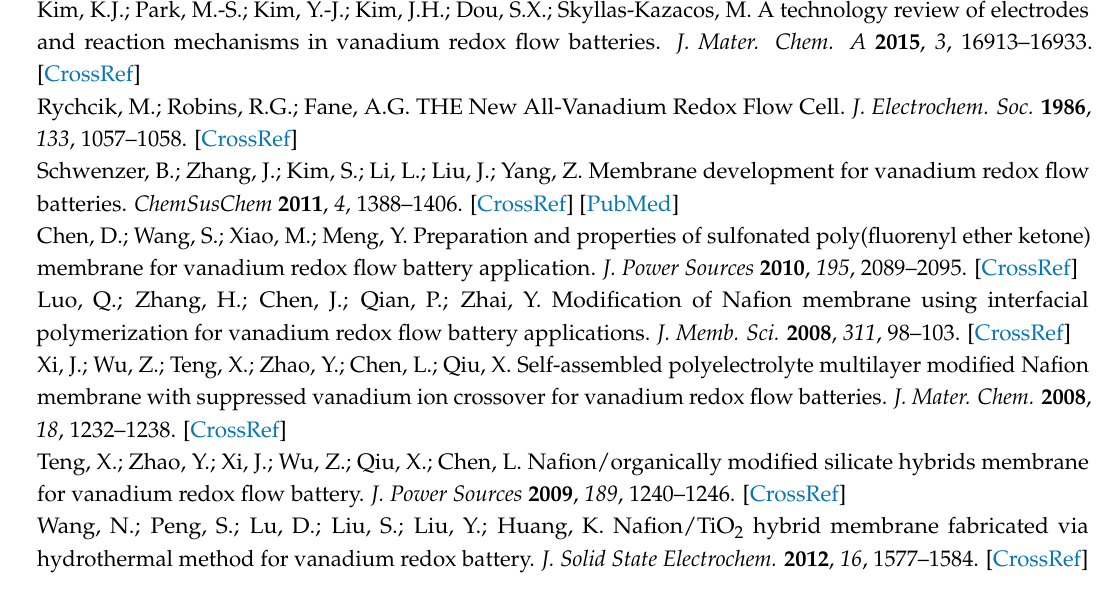
Figure S1: Anion exchange blend membranes tested in this study, Figure S2: Comparison of FT-IR spectrum of AEBMs with